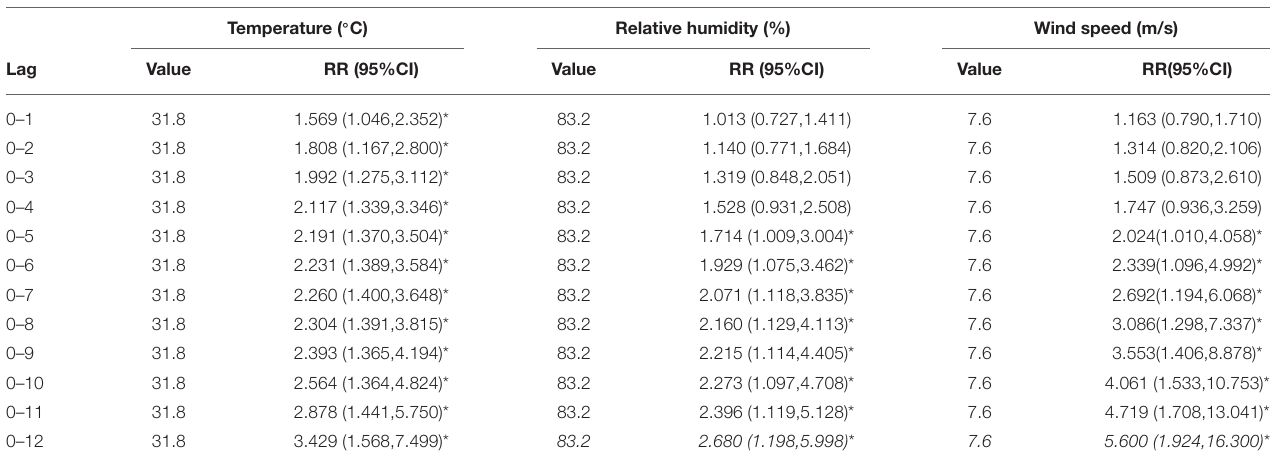
TABLE 4 | The largest cumulative effects of meteorological factors on PTB by lag